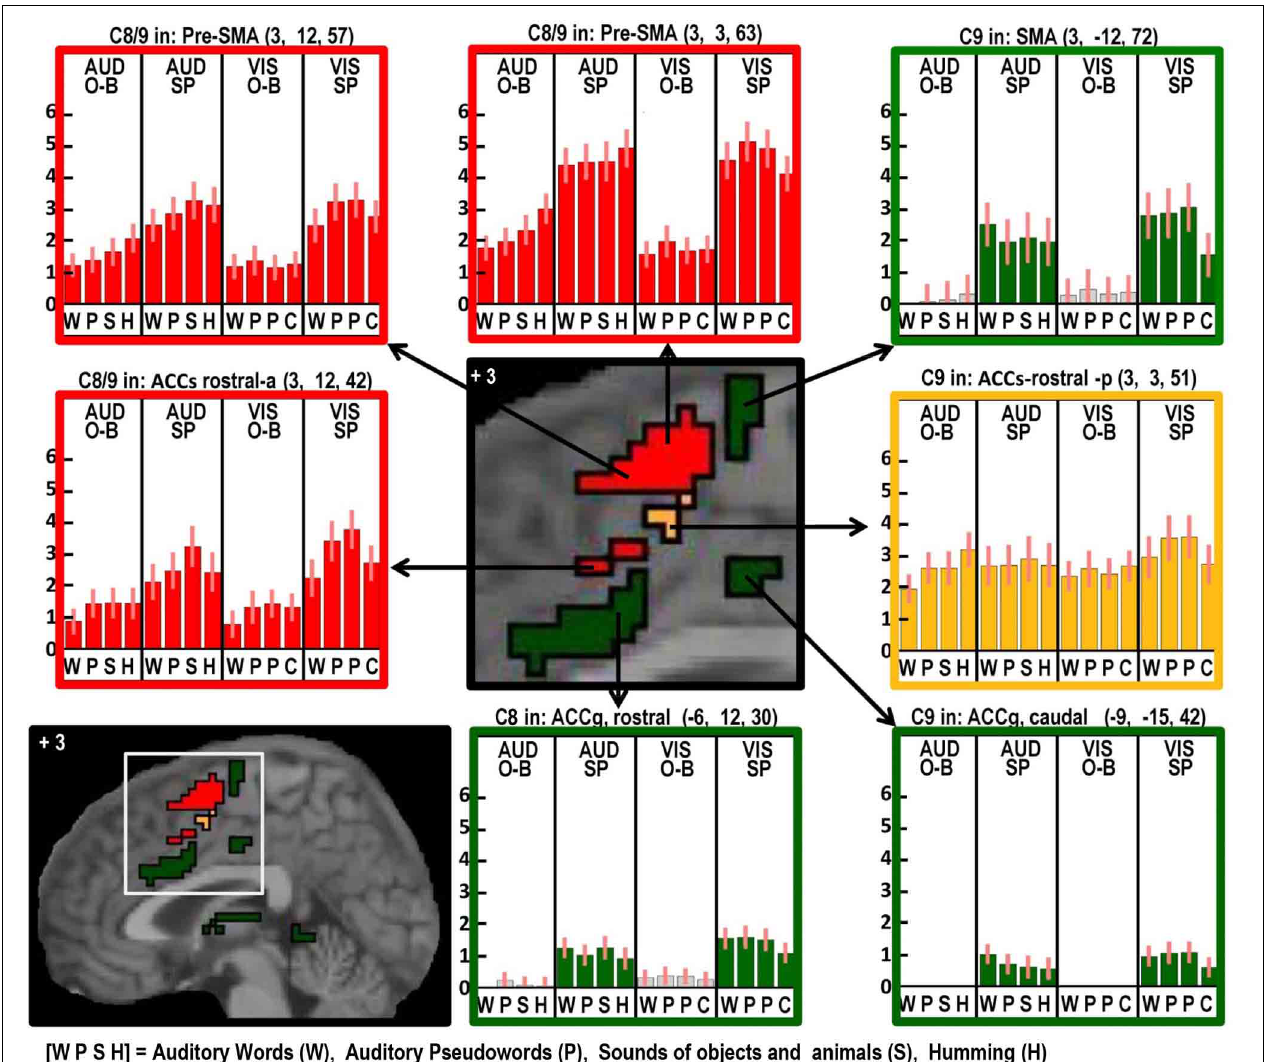
FIGURE 5 | As in Figures 2–4 but with effects located at x = + 3 in MNI space to highlight the many different effects in the anterior cingulate and supplementary motor